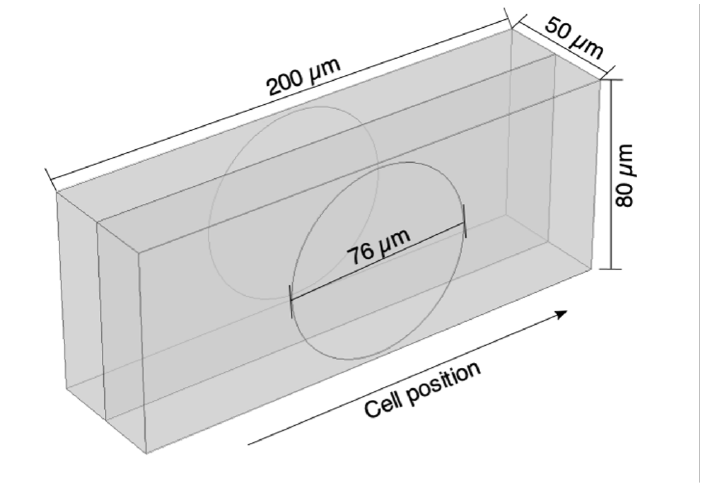
Figure A1. Schematic diagram of the model geometry representing the device design used in this